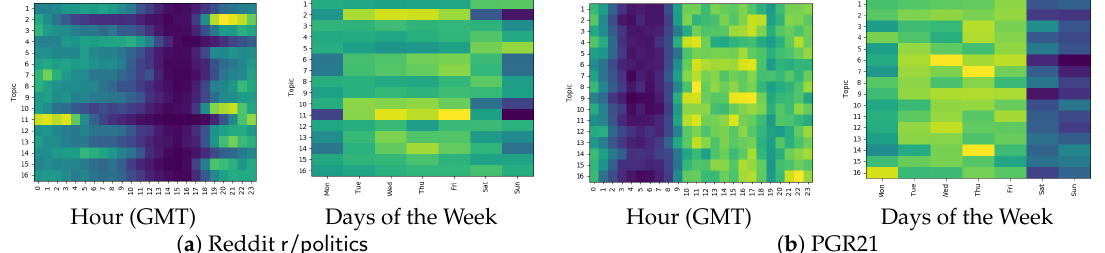
Figure 6. Active hours and days of the week for two different datasets.